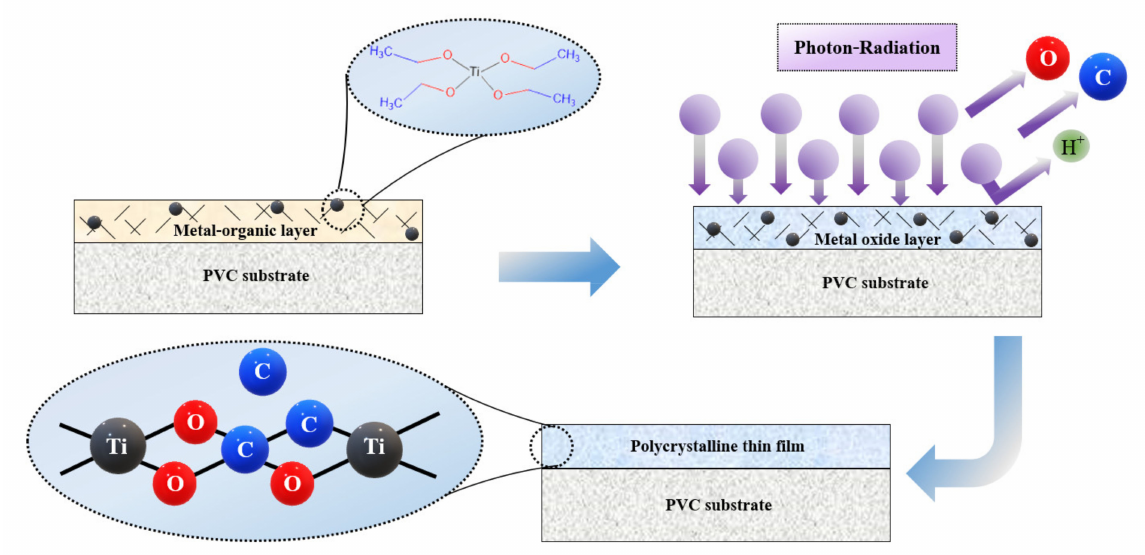
Figure 7. Summarization of the TiO 2 film growth